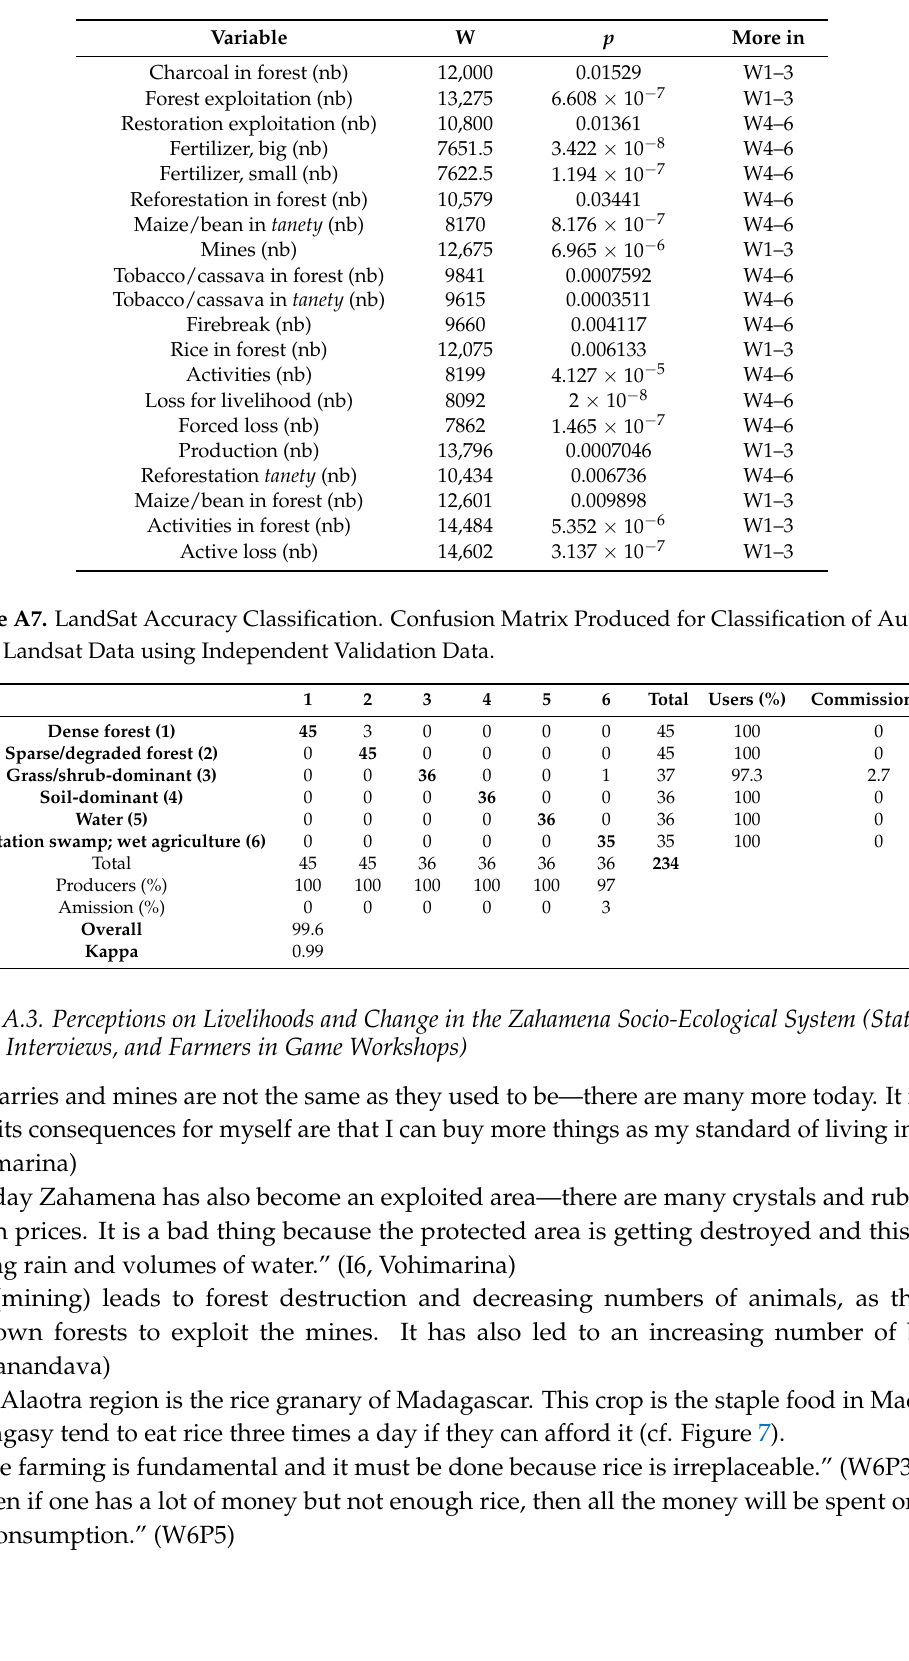
Table A6. Statistical Analysis of Players’ Gaming Behavior and Land-Type Changes. All game variables that showed a statistically significant difference between workshops 1–3 vs. 4–6 are listed below. A non-parametric Wilcoxon rank sum test with continuity correction was used with the R software version 3.0.3.